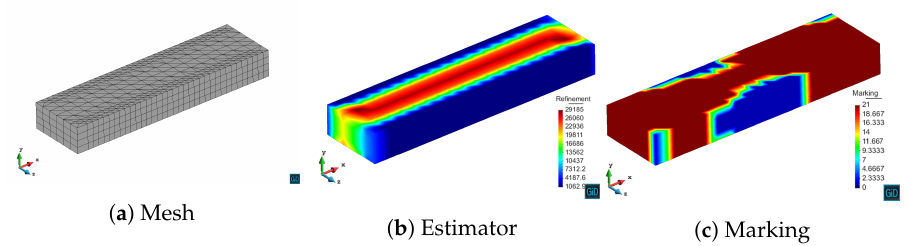
Figure 15. Second iteration for a structured mesh of a WR-90 waveguide.